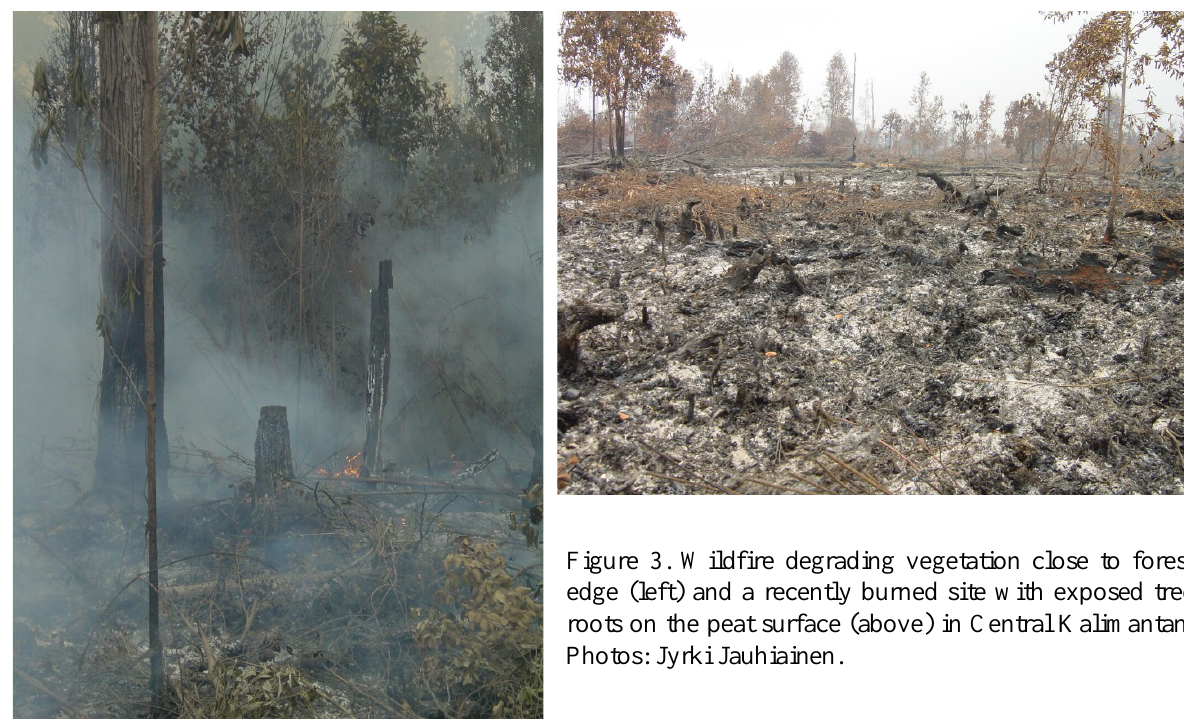
Figure 3. Wildfire degrading vegetation close to forest edge (left) and a recently burned site with exposed tree roots on the peat surface (above) in Central Kalimantan. Photos: Jyrki